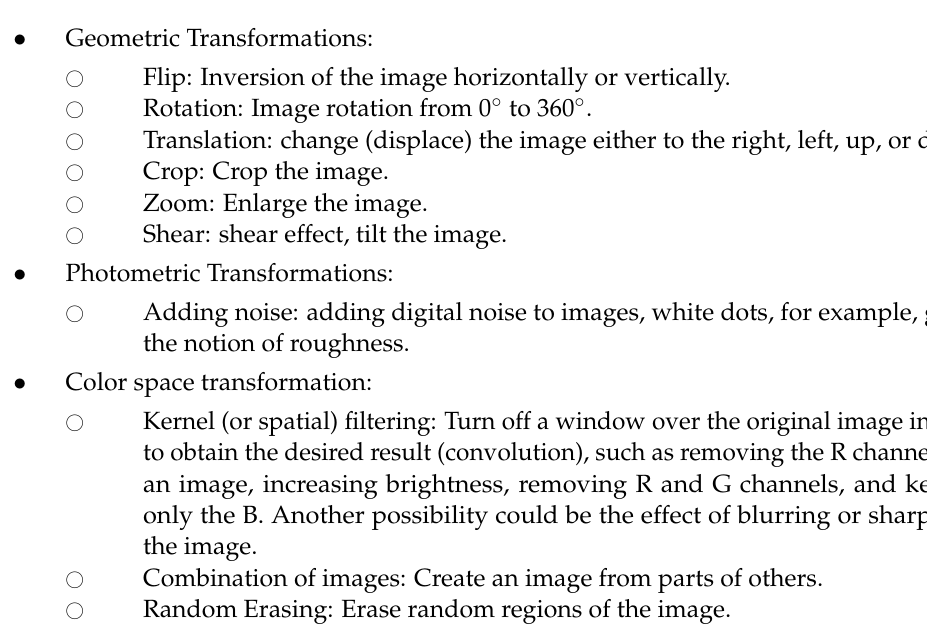
Figure 42. Data augmentation of the dataset used in the project [33].